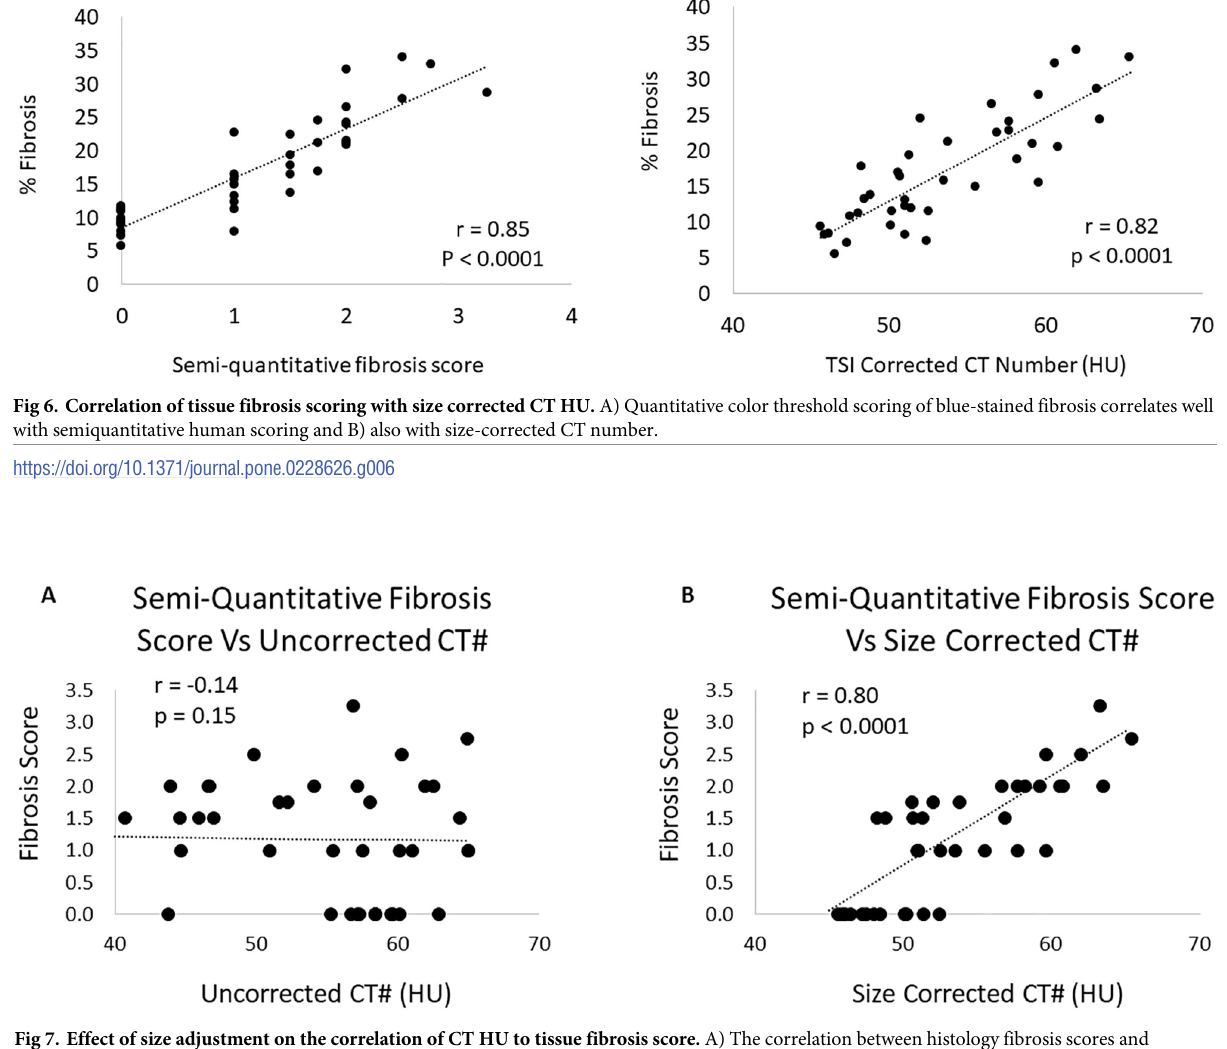
PLOS ONE | https://doi.org/10.1371/journal.pone.0228626 February 13,